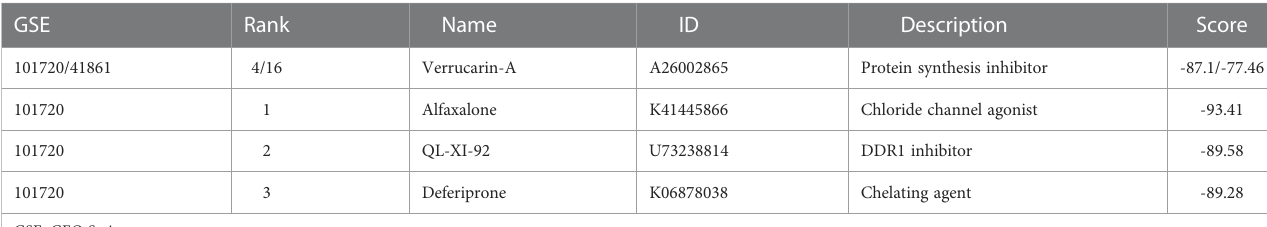
TABLE 6 Four compounds predicted using the CMap